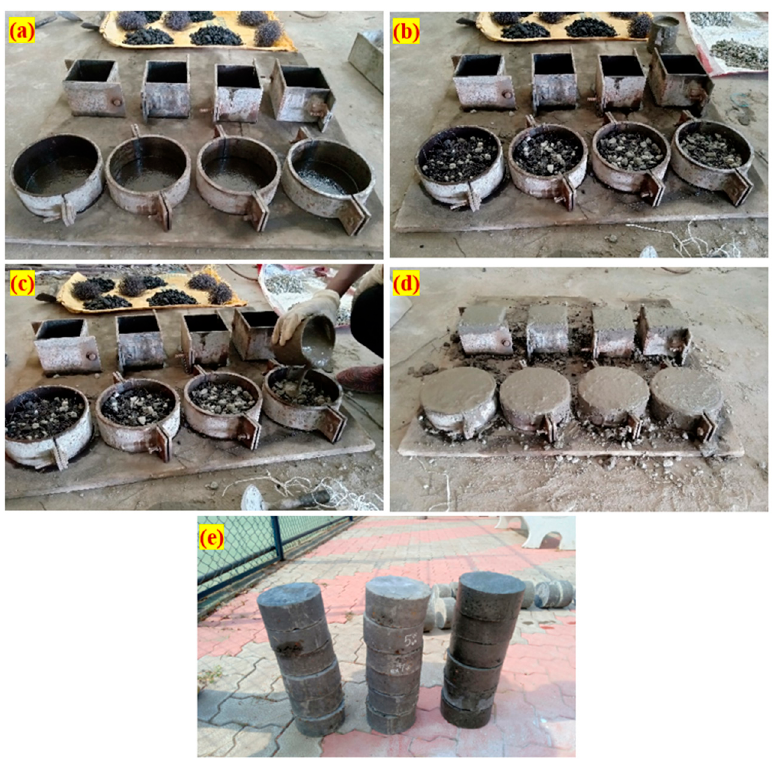
Figure 6. PAFC casting procedure ( a ) empty mold, ( b ) fibres and aggregates are filled in the mold, ( c ) grouting under gravity, ( d ) finished specimens and ( e ) specimens after demolding. Table 2. Mix combinations.